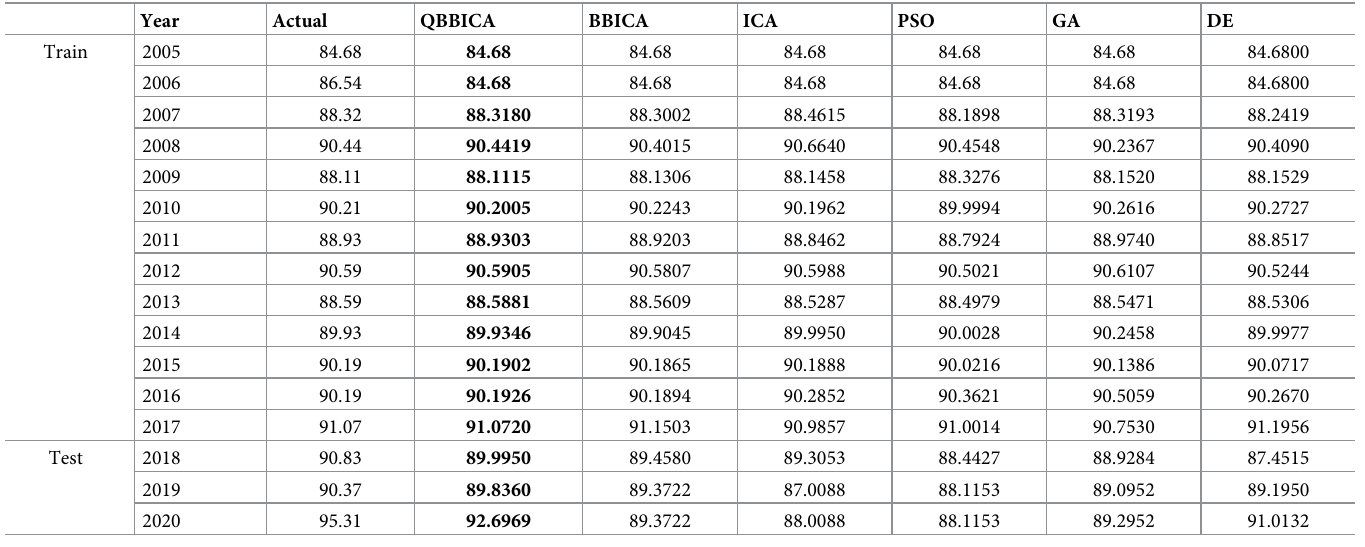
Table 6. Prediction results of ReLU-FCM trained by QBBICA, BBICA, ICA, RCGA, PSO and DE.